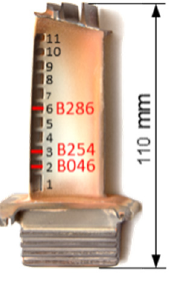
Figure 26. Damaged turbine blades. Table 7. Overview — turbine blades.